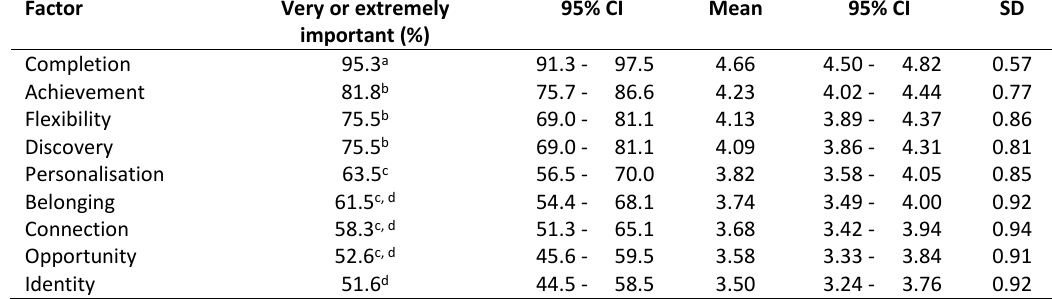
Table 1: Importance of factors in having a successful university experience (LT method)